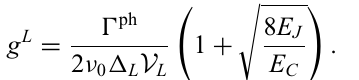
= 0.73 × 10 47 J − 1 m − 3 . For the dashed line in the left ν 0